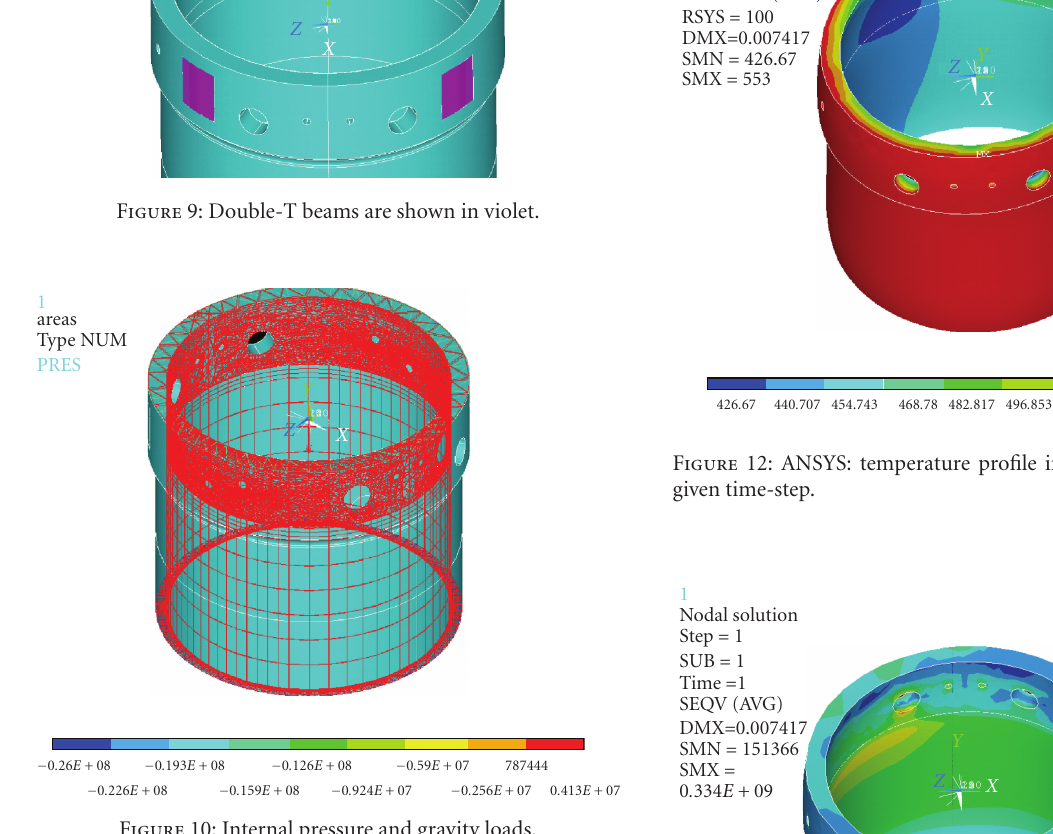
Figure 10: Internal pressure and gravity loads.